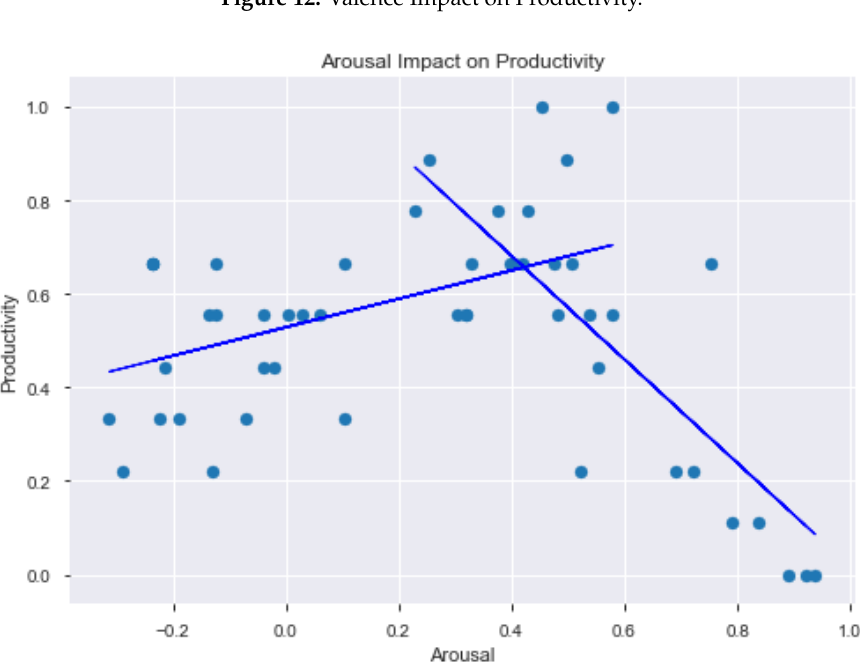
Figure 13. Arousal Impact on